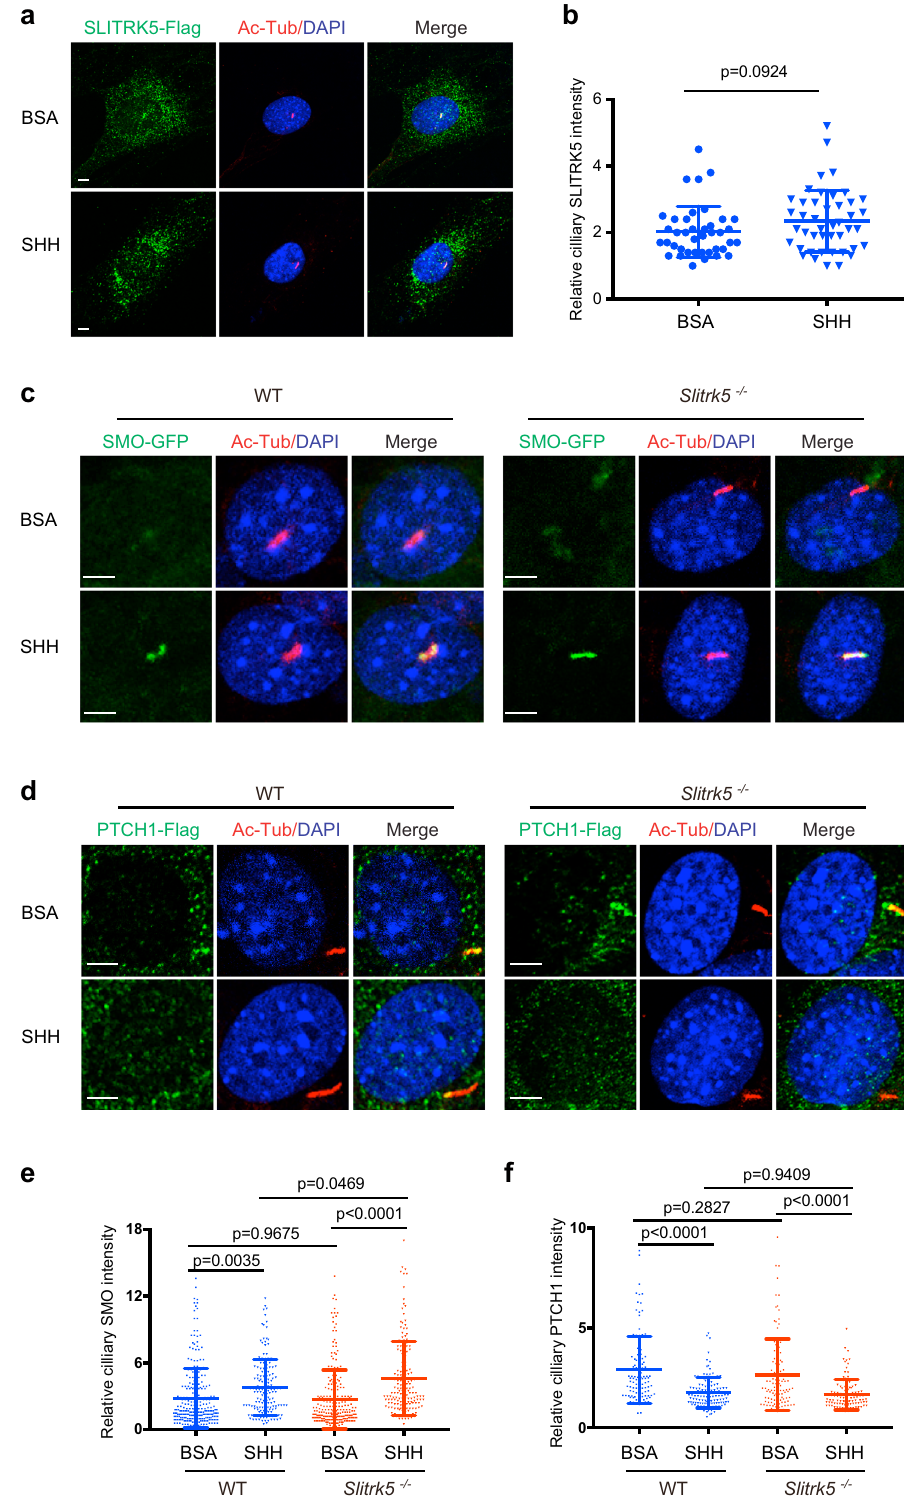
Fig. 4 SLITRK5 regulates SMO ciliary enrichment upon SHH stimulation. a Immunostaining for SLITRK5 (anti-Flag antibody, Green) and acetylated tubulin (Red) in osteoblasts treated with BSA or SHH for 4 h. Data are representative of three independent experiments, scale bar = 5 µ m. b Quanti fi cation of the relative fl uorescence intensity of ciliary SLITRK5- fl ag. n = 40 – 50 cells per group. Data are presented as mean ± s.d, two-tailed unpaired t test. c , d Ciliary localization of SMO-GFP ( c ) and PTCH1- Flag ( d ) in WT and Slitrk5 − / − osteoblasts treated with BSA or SHH for 4 h. Data are representative of three independent experiments, Scale bar = 5 µ m. e , f Quanti fi cation of the relative fl uorescence intensity of ciliary SMO-GFP ( e ) and PTCH1-Flag ( f ) in WT and Slitrk5 − / − osteoblasts treated with BSA or SHH for 4 h. n = 100 – 300 cells per group. Data are presented as mean ± s.d, One-way ANOVA ( P < 0.0001) followed by a Tukey ’ s post hoc